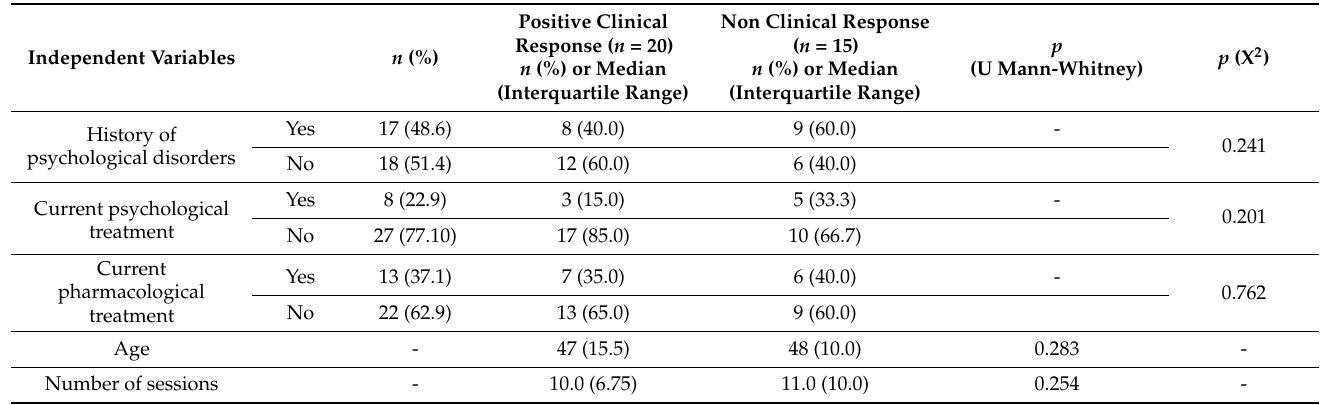
Table 3. Association between clinical response and age, pharmacological and psychological treat- ment, history of psychological disorders and number of immersive therapy sessions undertaken by professionals (Olot-Spain,